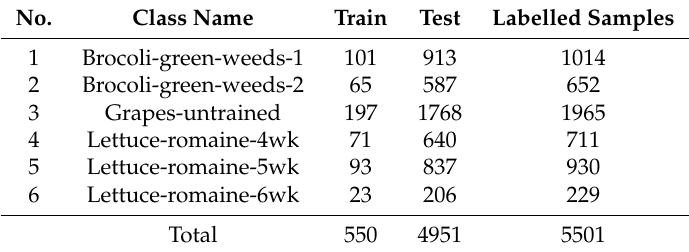
Table 7. Reference classes for the Salinas Scene data